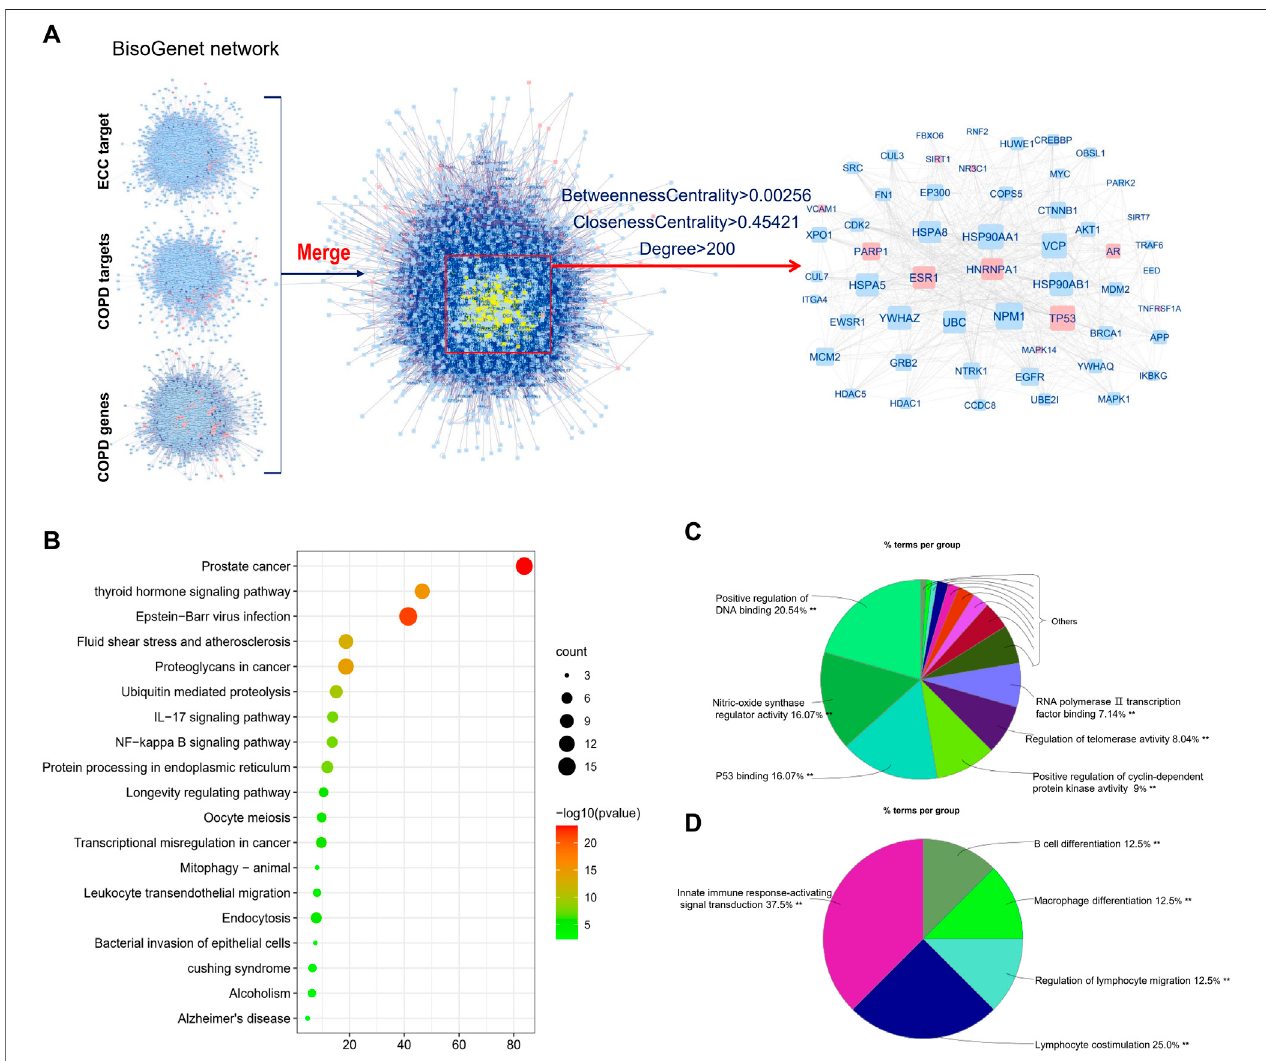
FIGURE4| Integrative analysisofECCtargets, and COPDgenesandtargets. (A) Hub-network extracted fromthemerged networkofECCtargets, COPDgenes, and targets. (B) Top20enriched KEGGpathways ofgenescontainedinthehub-networkconstructedusingMetascape. (C) Molecular functionand (D) immunesystem process analysis for the genes contained in the